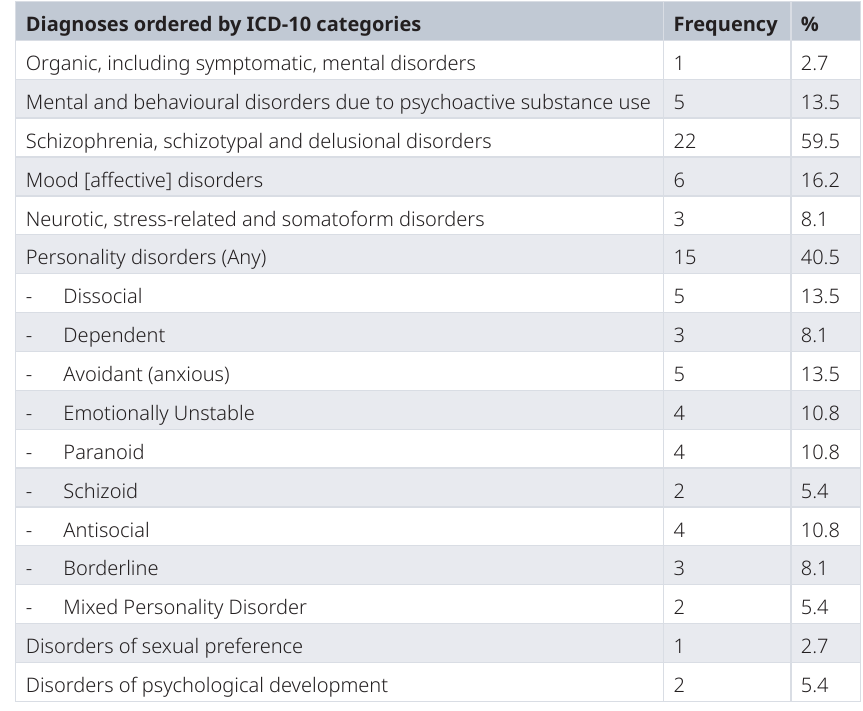
Table 3. Mental health diagnoses in the